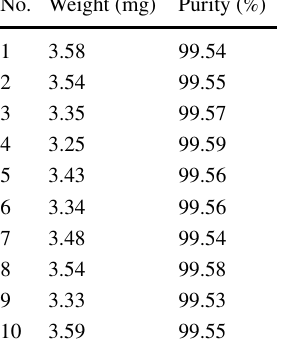
Table 6 Melting enthalpy